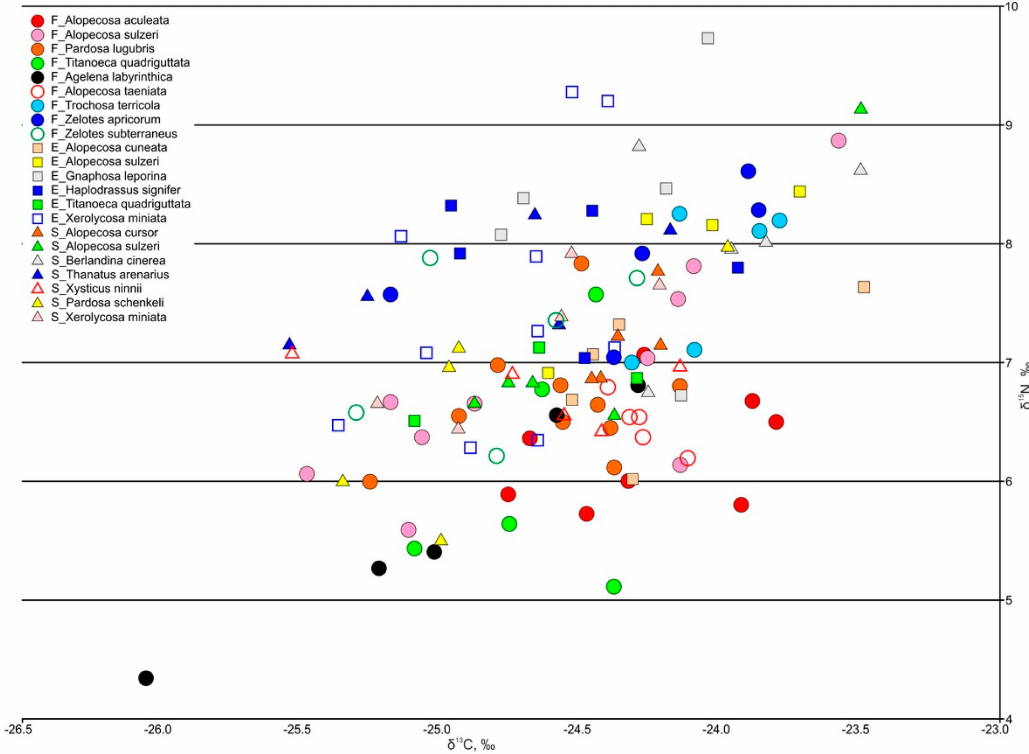
Figure A4. Distribution of spiders of the studied ecosystems in the δ 13 C– δ 15 N isotopic biplot. Each symbol shows one specimen. F: forest (circles), E: edge (squares), S: steppe